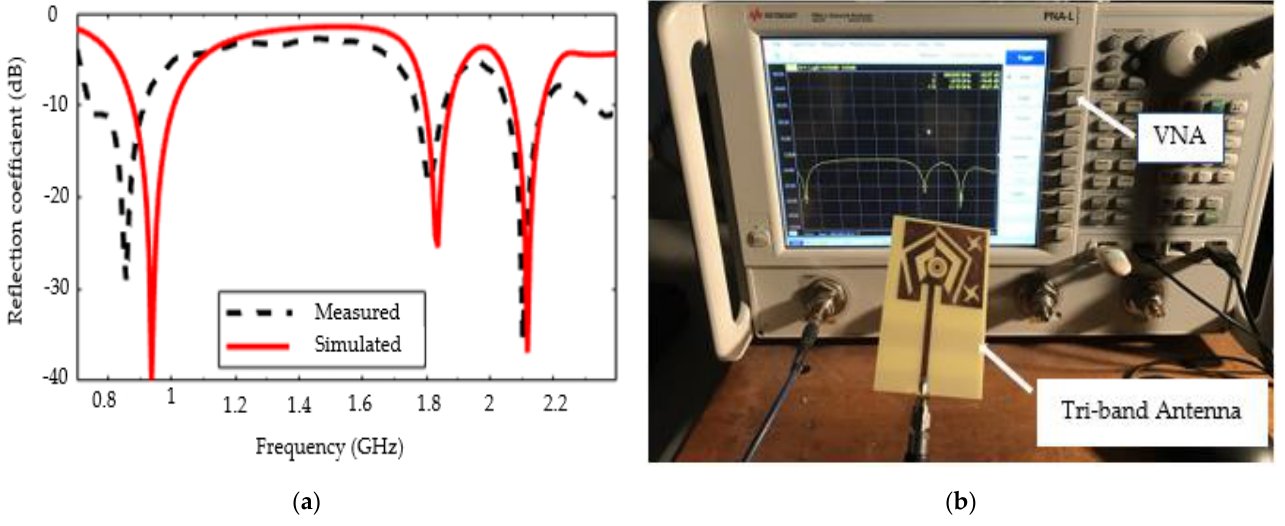
Figure 9. Reflection coefficient: ( a ) Simulated and measured results (in dB); ( b ) experimental setup.